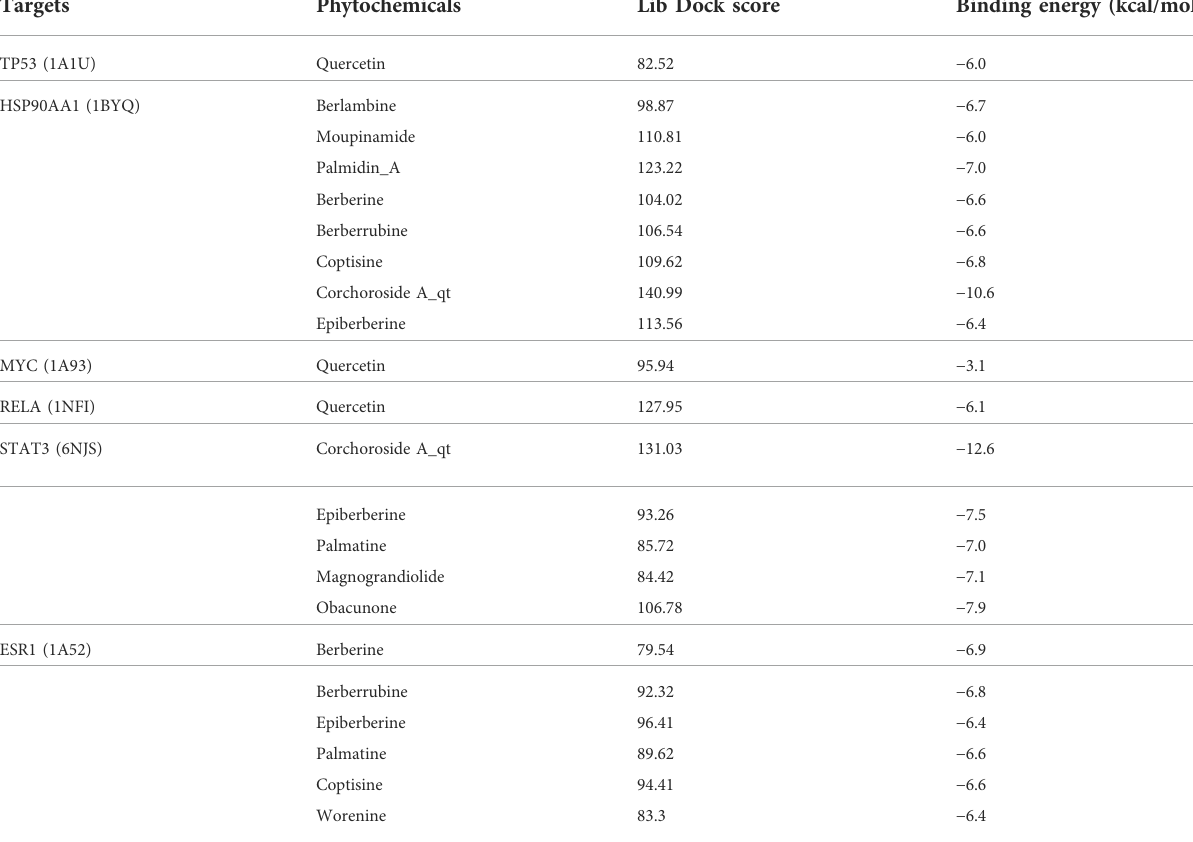
TABLE 4 Molecular docking of core targets and key phytochemicals.